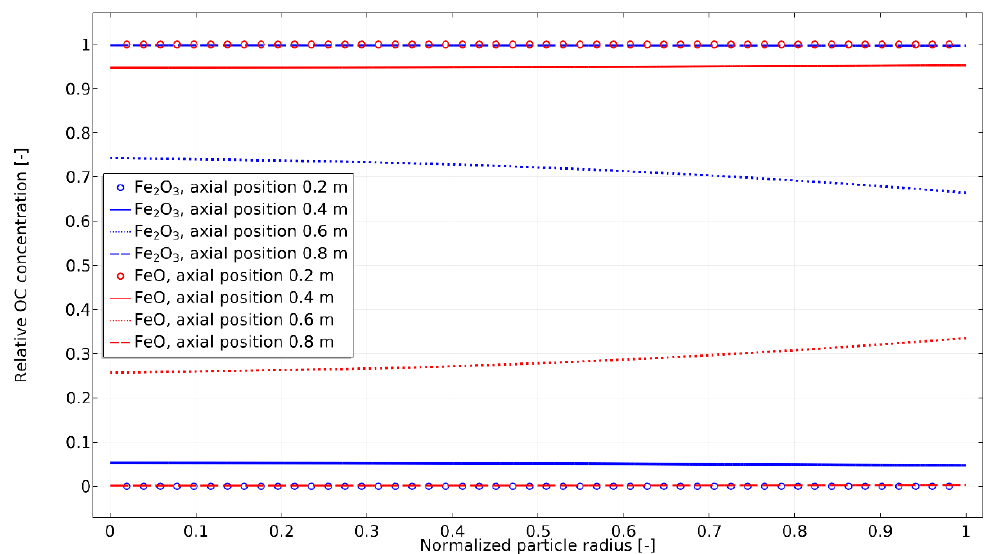
Figure 5. Axial concentration in the fuel reactor at different moments in time during reduction with H 2 .